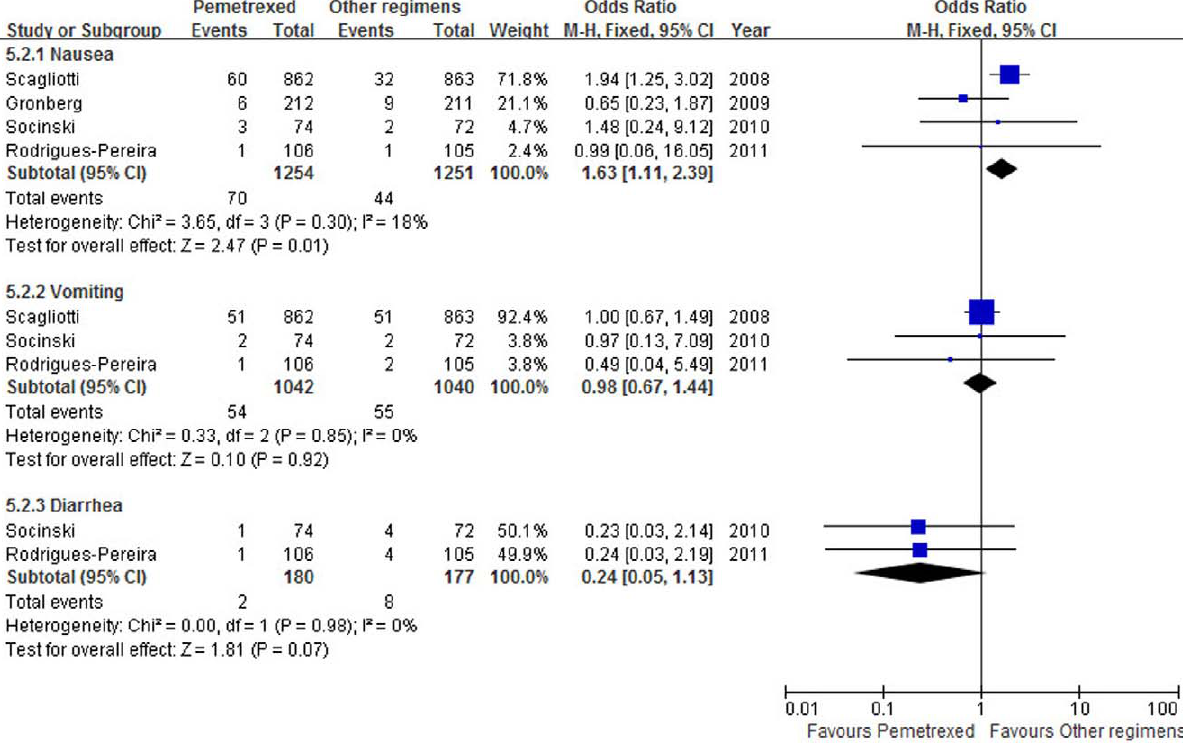
Figure S1 The flow of the included studies.